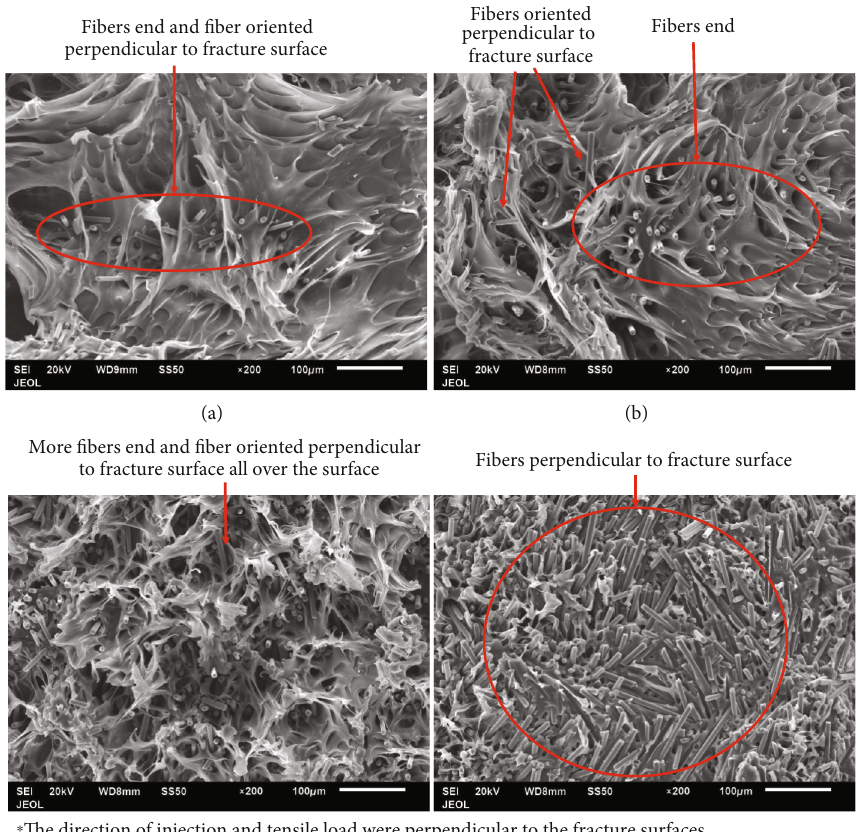
Figure 9: SEM images of tensile fracture surface for (a) PP/15SCF, (b) PP/20SCF, (c) PP/30SCF, and (d) PP/40SCF composites. Fiber on the core oriented parallel to the fracture surface